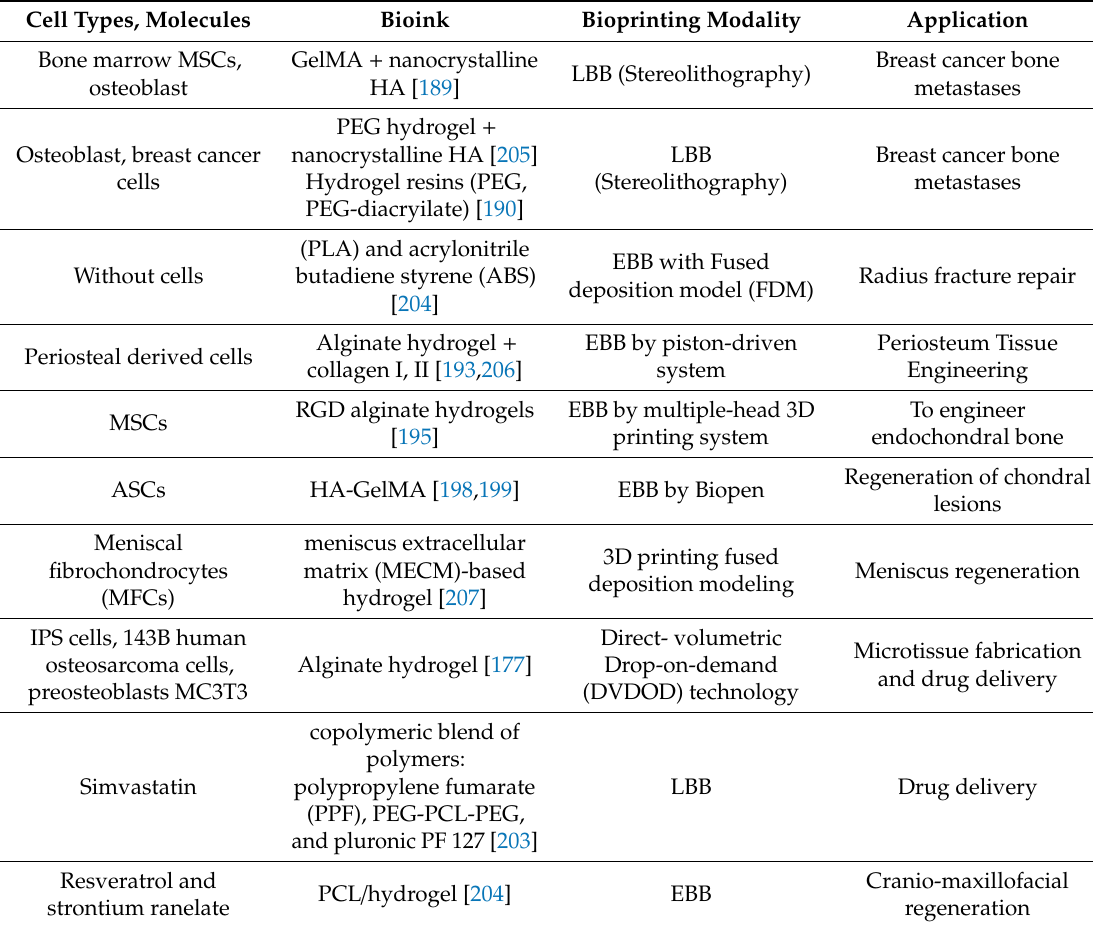
Table 2. Applications of 3D Bioprinting on bone